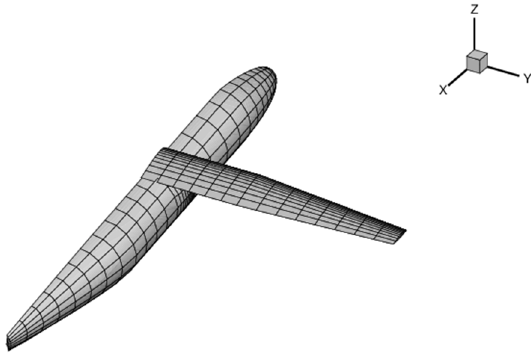
Figure 11. Half the span of the airframe structured-surface meshing.